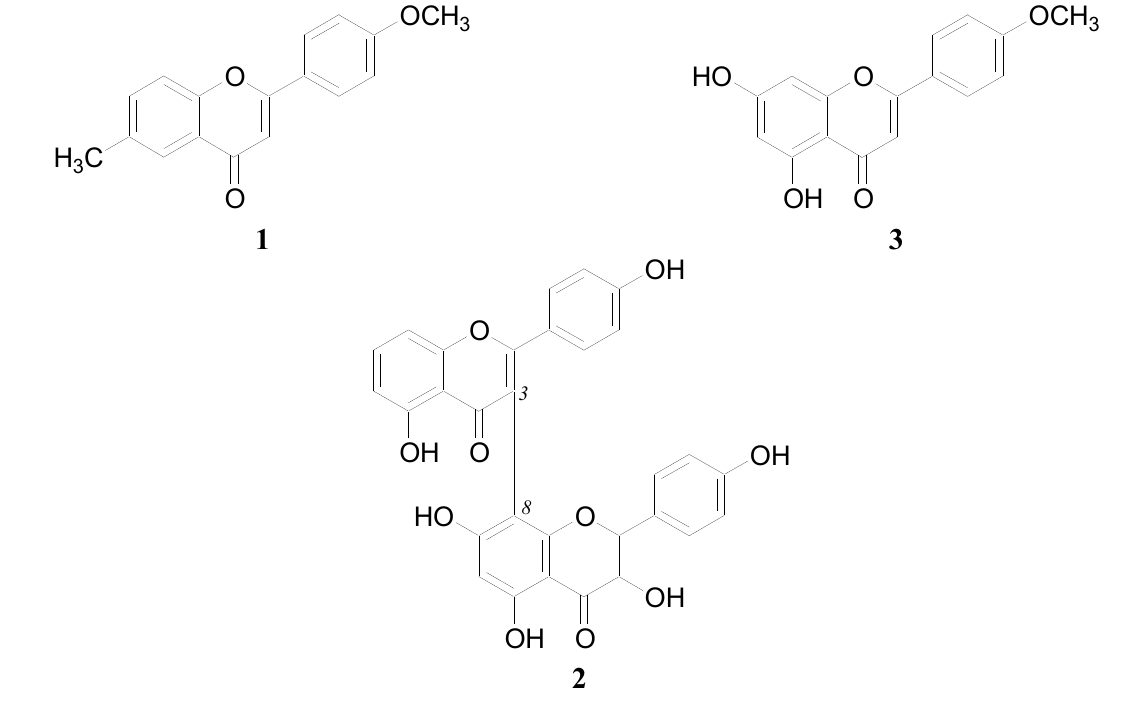
Table 1. 1 H-NMR and 13 C-NMR data for 2 in DMSO- d